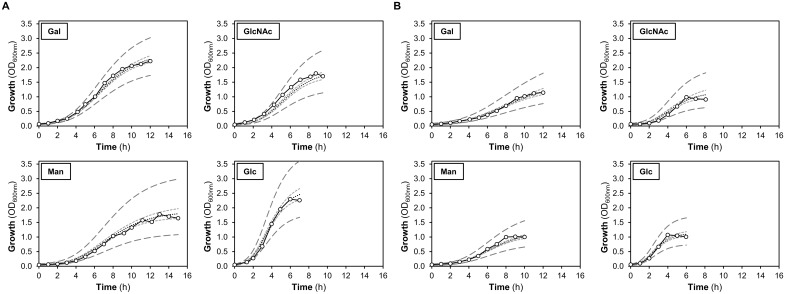
Representative growth profiles of S. pneumoniae D39 grown in CDM in the presence of two different concentrations of galactose (Gal), N-acetylglucosamine (GlcNAc), mannose (Man) or glucose (Glc).Growth profiles in 80 ml batch cultures using (A) excess substrate concentration (34±2 mM) and (B) a 3-fold lower initial substrate concentration (13±1 mM). Representative growth curves (empty dots) were selected based on the established criterion (see Materials and Methods). The experimental data was fitted using the Gompertz model with all replicates (estimated curve in black dashed line) and the 95% confidence bands (small dashed light grey lines) and 95% predicted bands (big dashed dark grey lines) were determined (see Materials and Methods). Growth was performed at 37ºC, under semi-anaerobic conditions, without pH control (initial pH 6.5). Growth curves are plotted in decimal scale to allow the visual discernment between significantly differences in the growth parameters using the two initial substrate concentrations.